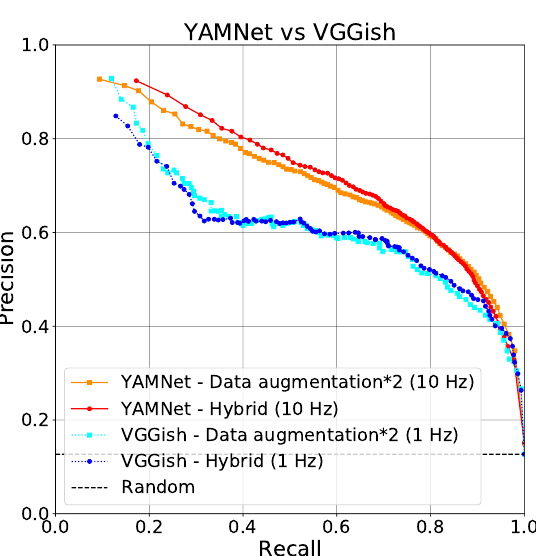
Figure 4. Precision–Recall curves comparing YAMNet and VGGish’s best-performing configurations.